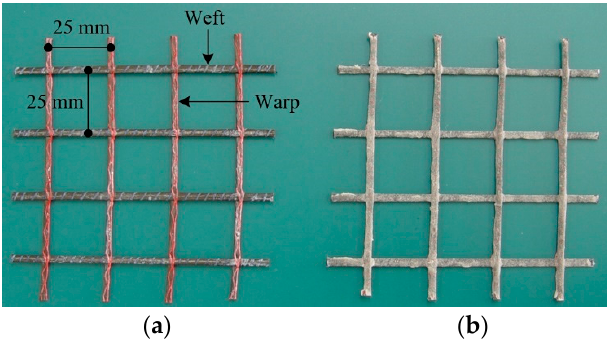
Figure 1. Carbon textile grid. ( a ) As-delivered condition; ( b ) Surface coated by Al 2 O 3 powder. Table 1. Material properties of carbon grid-type textile in warp direction (suggested values by the manufacturer).